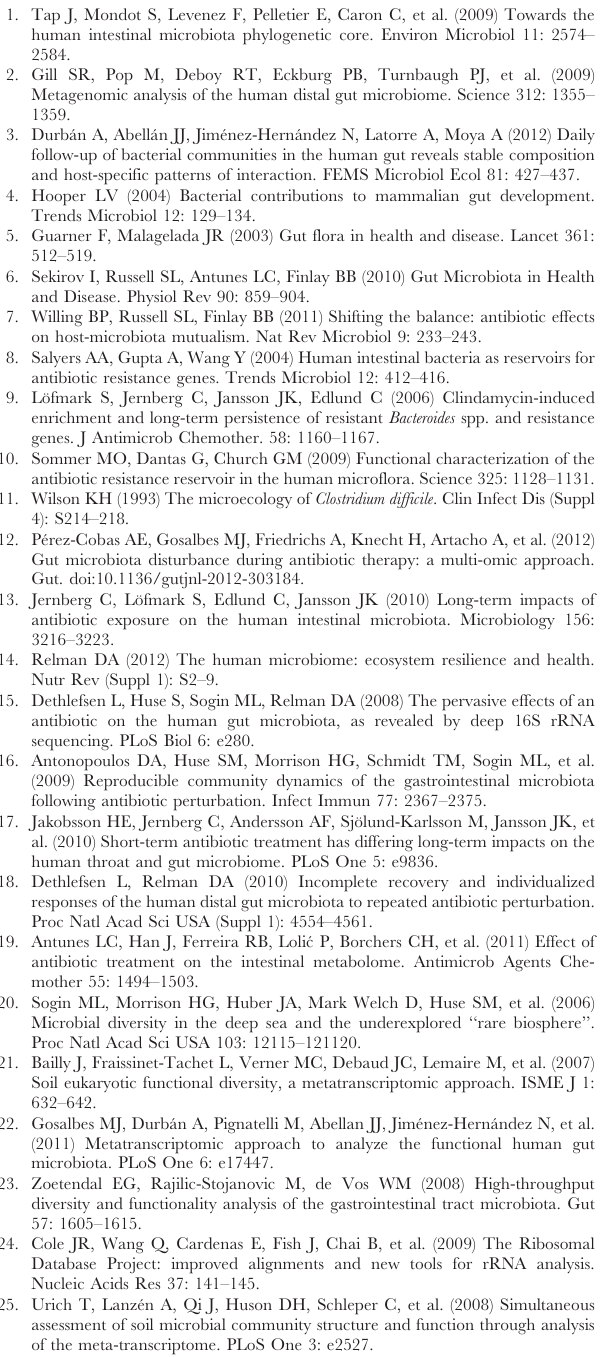
Figure S1 Evolution of diversity parameters along the treatment for patient A, B, C, and D. (A) Shannon Index. (B) Richness estimators: N, Chao1 and ACE. N is the number of observed taxa. Figure S2 Abundance of the main functional roles for all the